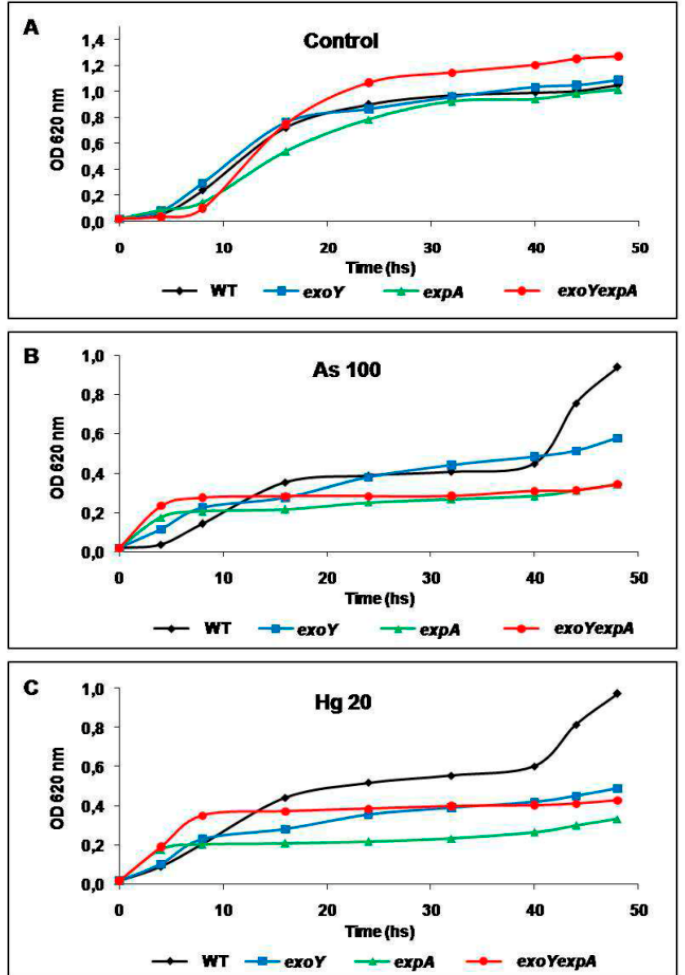
Figure 1. Growth curves of S. meliloti strains. Rm8530 wild type (WT) strain and Rm8530 strain mutants in the synthesis of EPS I ( exoY ), EPS II ( expA ), and both EPSs ( exoYexpA ) were grown for 48 h in TY medium without metals added (control) ( A ); and in TY medium supplemented with NaAsO 2 100 µ M (As 100) ( B ); and HgCl 2 20 µ M (Hg 20) ( C ). Each point represents the media value of three different assays performed in triplicate. Error bars are omitted for a better visualization of the graphic. Table 1. Bacterial counts of S. meliloti strains exposed to metals.